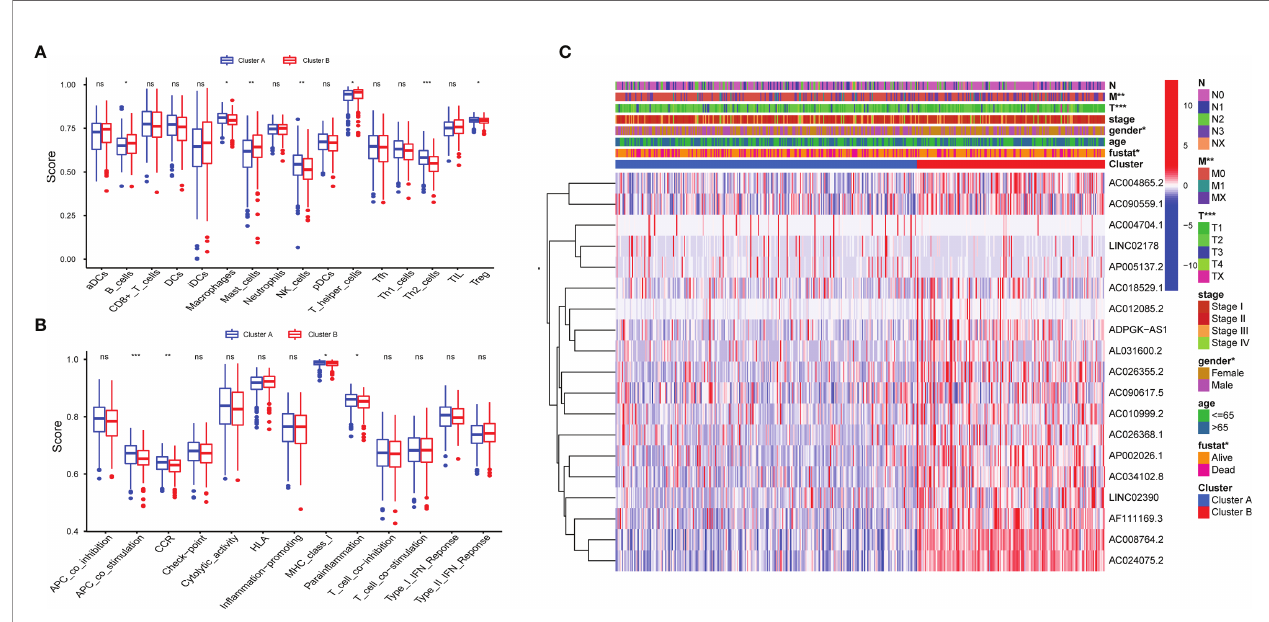
FIGURE 3 | Distinct Clinical characteristics and immune cell in fi ltrations and function with molecular patterns in LUAD. (A, B) The enrichment scores of 16 immune cells (A) and 13 immune-related functions (B) ;*P < 0.05, **P < 0.01, ***P < 0.001, and ns P > 0.05. (C) Heatmap of correlation of the two clusters with clinicopathologic features.